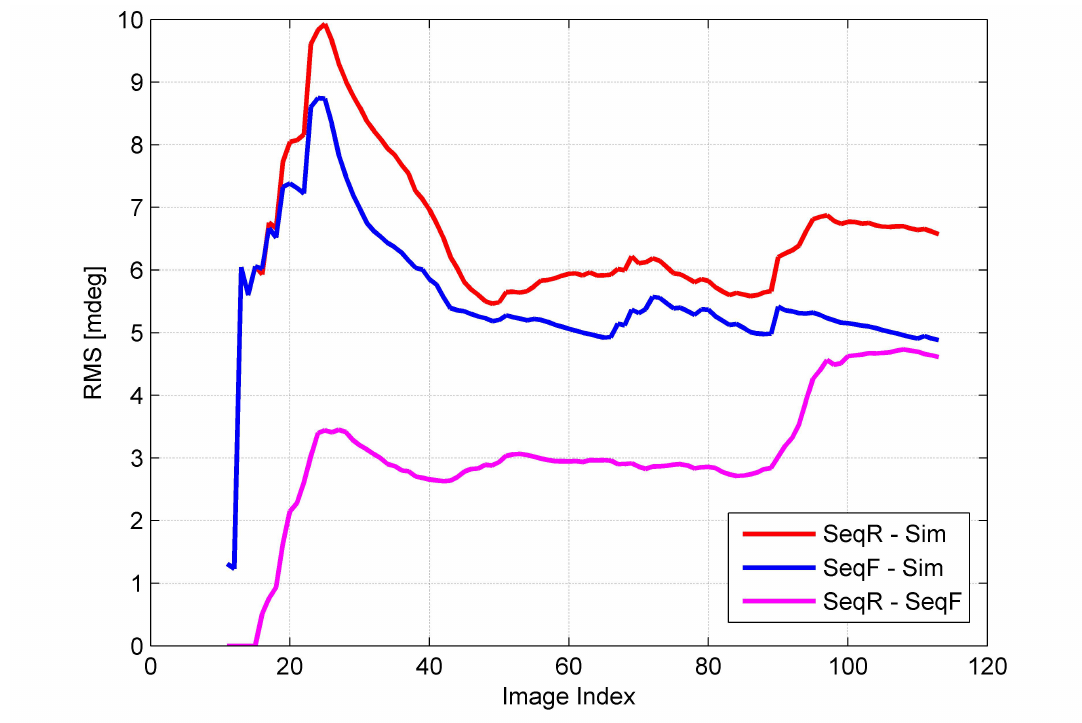
Figure 16. RMS values of EOP differences (attitude).